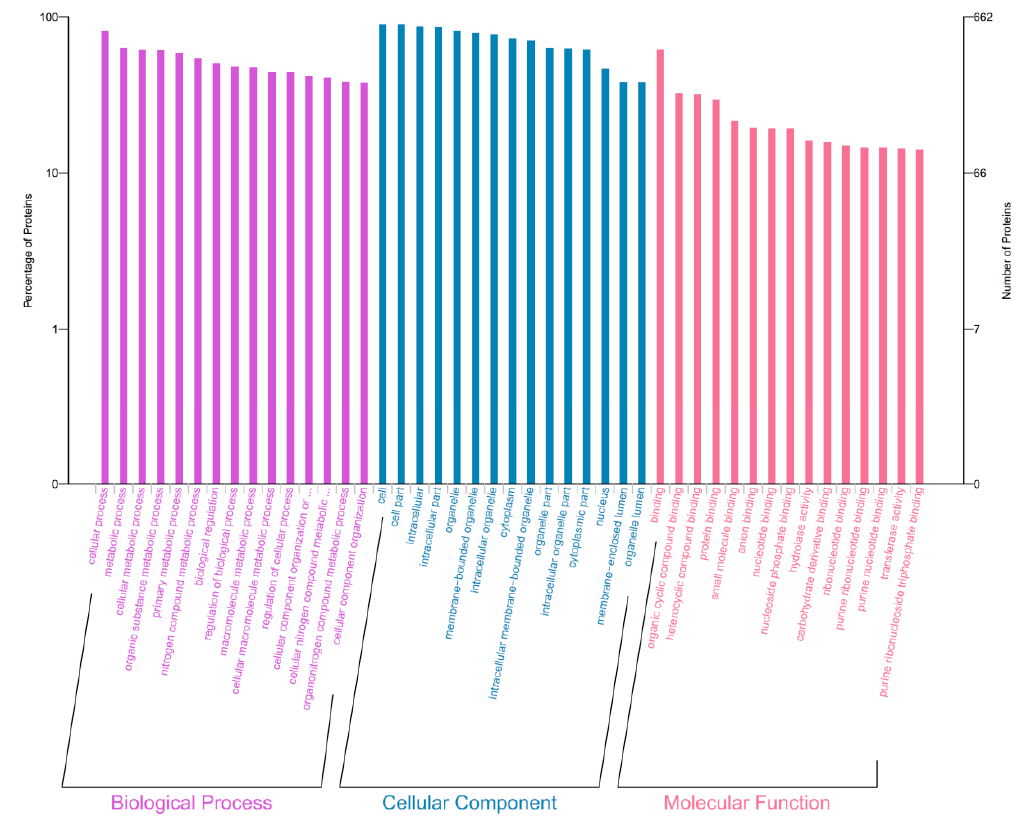
Figure 4. The results of Gene Ontology (GO) enrichment analysis of the differentially expressed proteins.